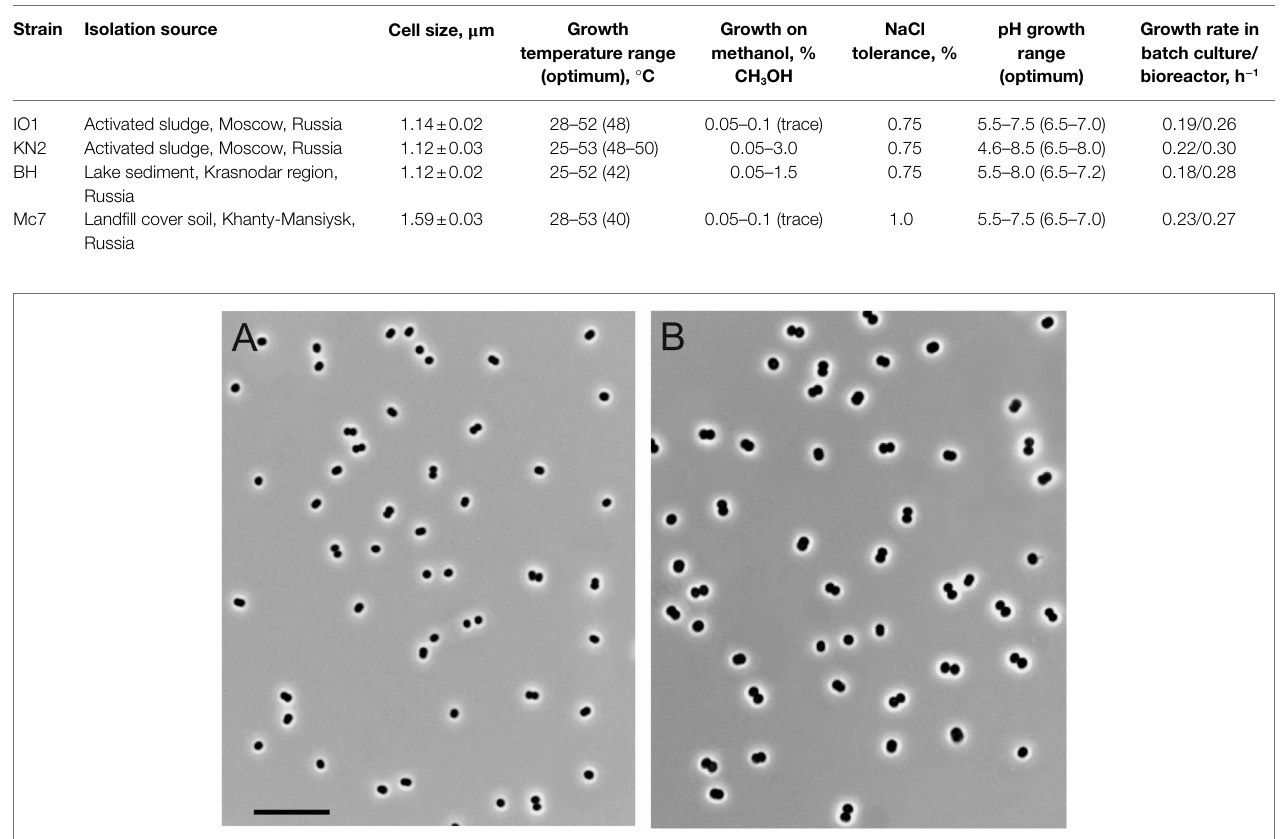
FIGURE 1 | Cell morphology of strains KN2 (A) and Mc7 (B) grown for 1 day in liquid medium mAMS with methane. Marker, 10 μ